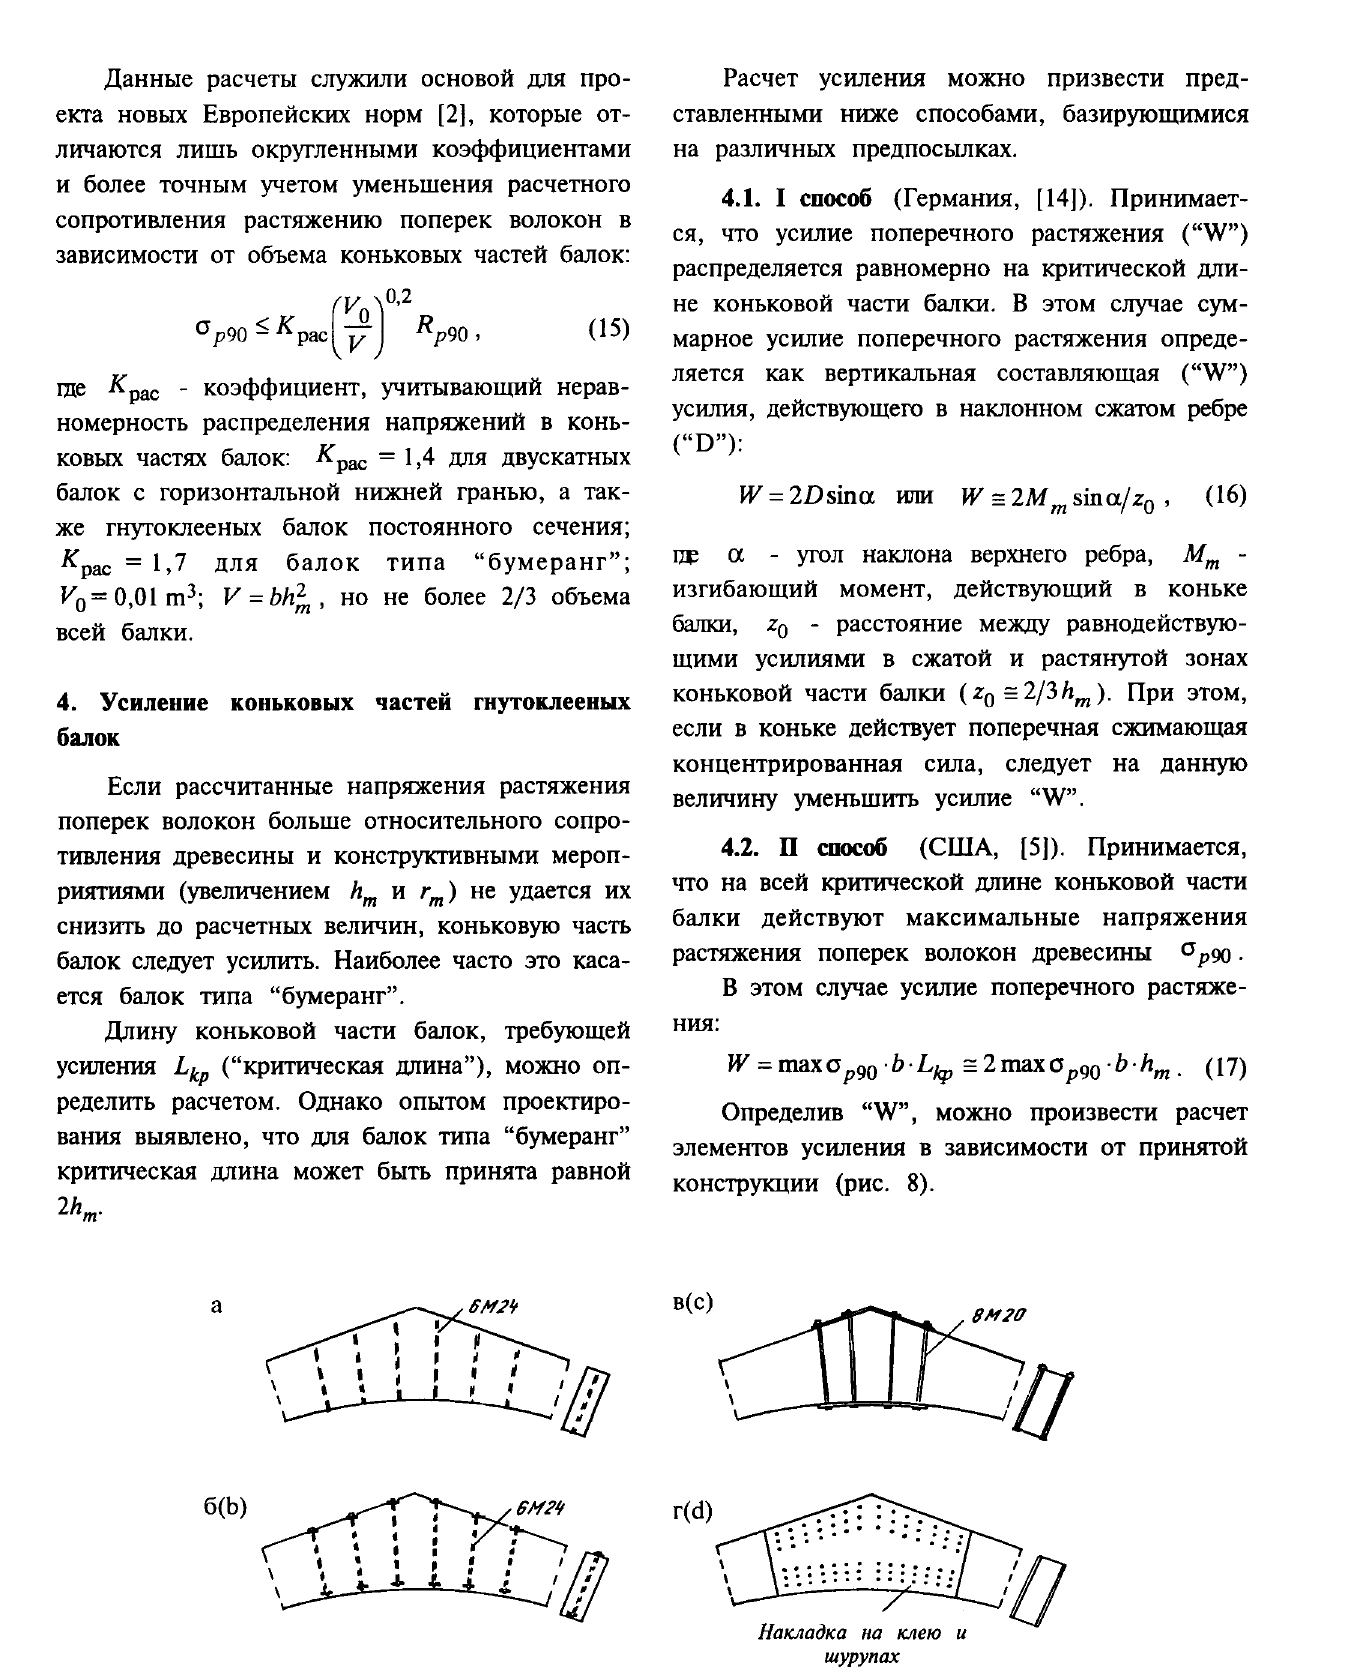
Fig 8. Examples of strengthening of apex zone of pitched cambered beaJTI..S under lateral tension: a - glued in rods; b - internal bolts; c - external bolts; d - side plates -